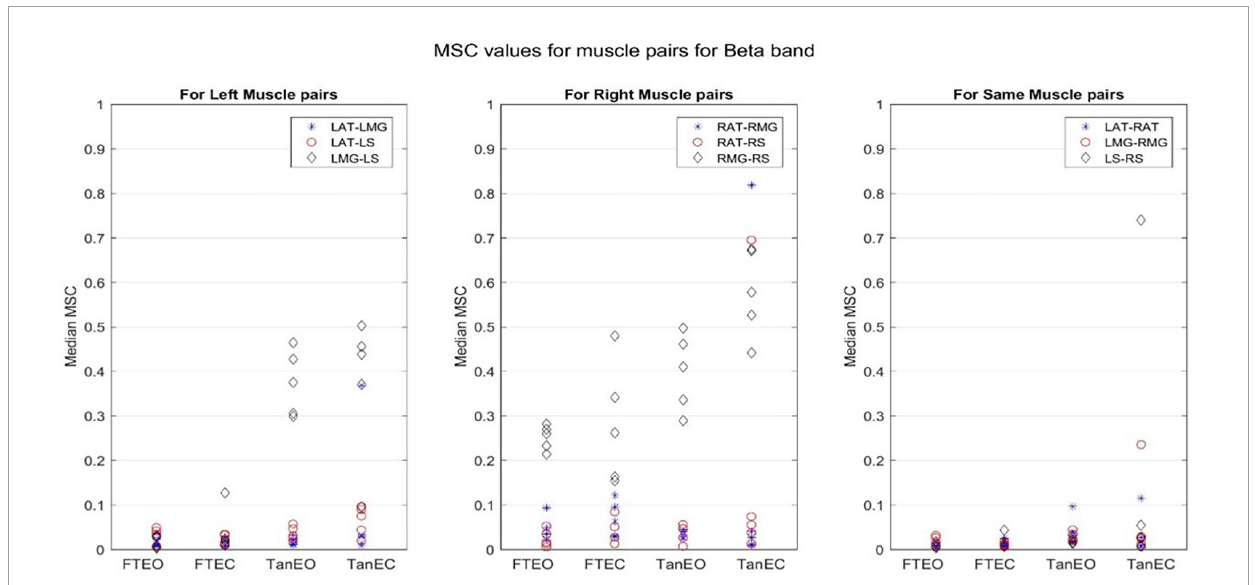
FIGURE5 Magnitude-squared-coherence plot for different muscle pairs under different standing conditions for beta frequency band (14.0625–32.8125 Hz) for a single participant for all individual trials. The plot shows coherence between different muscle pairs for the most to least stable postural standing positions in the beta band. It can be seen how coherence for different muscle pairs have increased mainly in the right leg between RMG and RS on moving to lower frequency